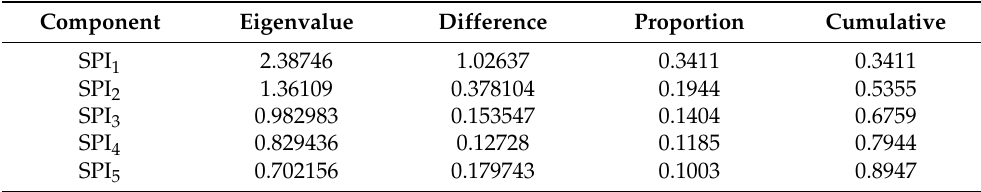
Table 6. The eigenvalue fragments in the correlation matrix and the selection of social development indicator priorities.